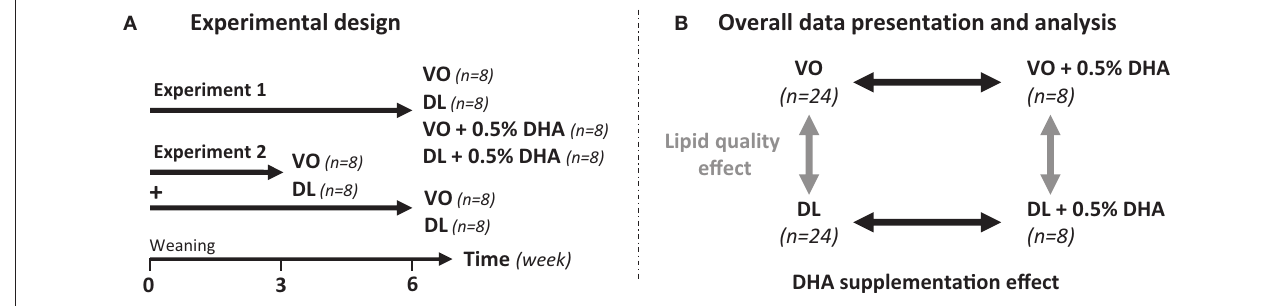
FIGURE 1 | (A) Study design including two experiments. In experiment 1 ( n = 8/group), rats were fed from weaning for 6 weeks with the vegetable oil blend diet (VO) or the vegetable oil and dairy lipid blend diet (DL), not supplemented or supplemented with 0.5% DHA (VO + DHA and DL + DHA). In experiment 2 ( n = 8/group), rats were fed the VO or the DL diet from weaning for 3 or 6 weeks. The two experiments were performed at 1-year interval. (B) Data presentation and statistical analysis strategies. Results are presented as mean ± SEM of combined groups from experiments 1 and 2. Consequently, a linear mixed-model with 2 fixed factors and 2 hierarchized random effects (experimentation/duration of diet) was used for statistical analysis.